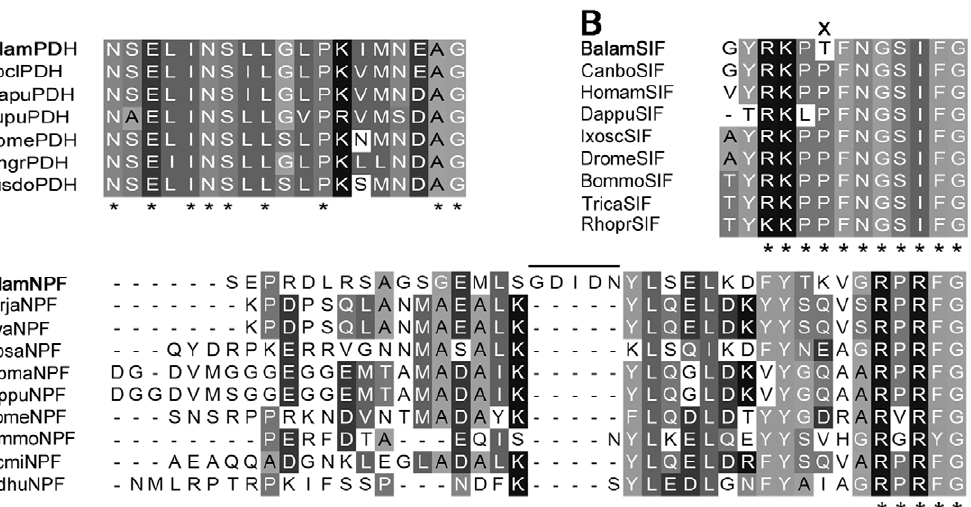
Figure 1. Sequence alignment of barnacle pigment dispersing hormone, SIFamide and neuropeptide F with arthropods. (A) Sequence alignment of mature pigment dispersing hormone. Decapods peptide sequences are from: Uca pugilator P08871, Procambarus clarkii Q9TWW7 and Cancer productus ABV68725; isopod peptide is from Eurydice pulchra ACX49752; insect peptides are from: Drosophila melanogaster AAL49303, Schistocerca gregaria ACY02888 and Musca domestica Q76JT9. (B) Alignment of barnacle SIFamide mature peptides. Sequences are from: decapods Homarus americanus , Cancer borealis ; branchiopod Daphnia pulex ; insects Drosophila melanogaster , Tribolium castaneum , Bombyx mori , Rhodnius prolixus and Ixodes scapularis [38]. (C) Alignment of barnacle NPF mature peptide. Insect NPF are from: Drosophila melanogaster AF117896, Bombyx mori NP_001124361, Locusta migratoria CO854418 and Pediculus humanus EEB15547. Decapods NPF are from shrimps Marsupenaeus japonicus CI998017 and Litopenaeus vannamei AEC12204; copepod NPF is from Lepeophtheirus salmonis FK933794; branchiopods NPF are from